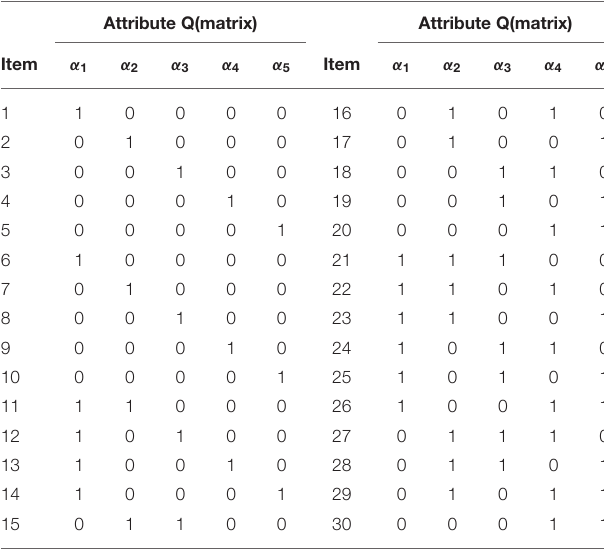
TABLE 1 | The Q matrix design in the simulation study